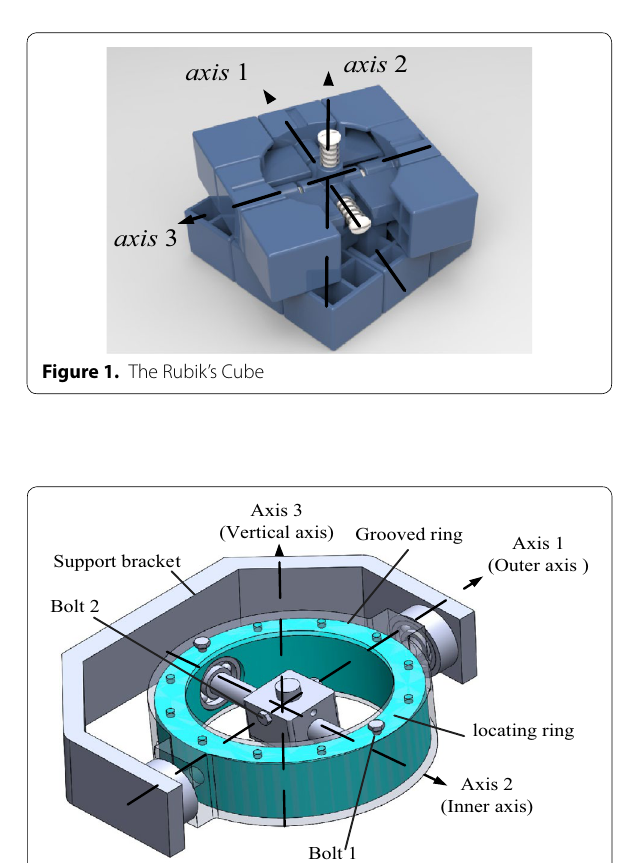
Figure 2. The rA reconfigurable